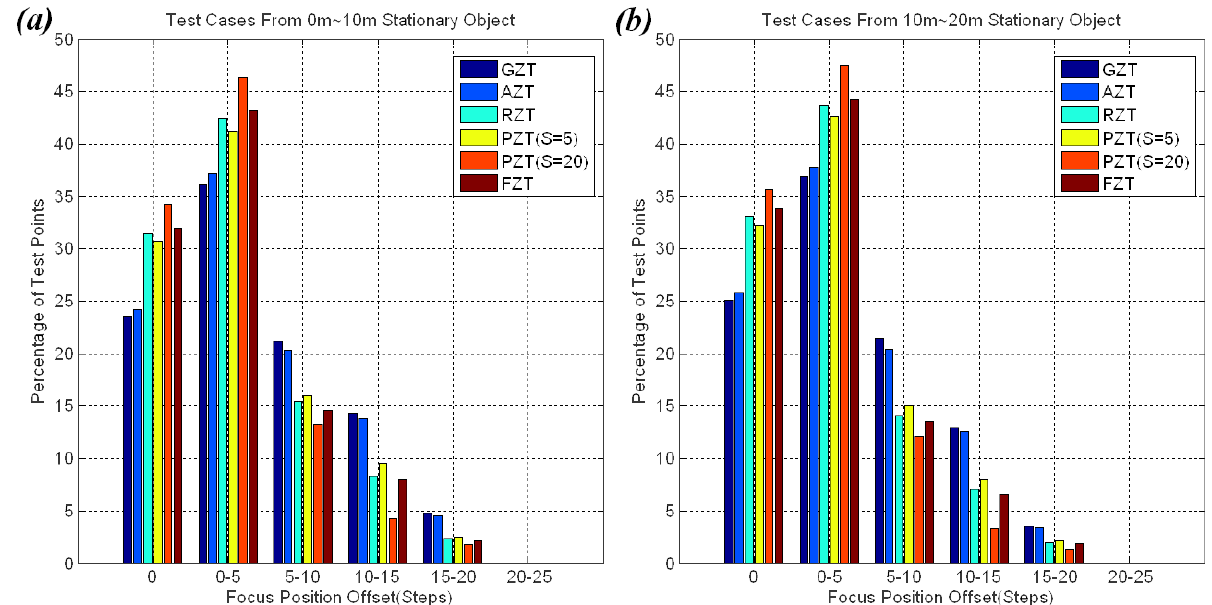
Figure 14. Offset distribution for stationary objects.